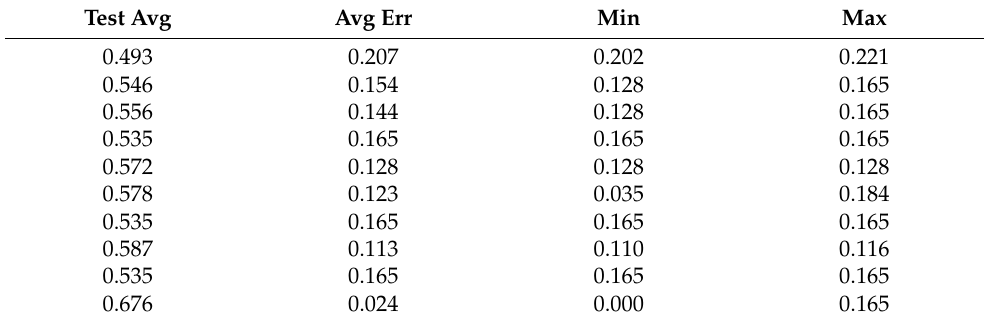
Table A207. Set 3, trials 31–40 data (all 0.5 PR values).